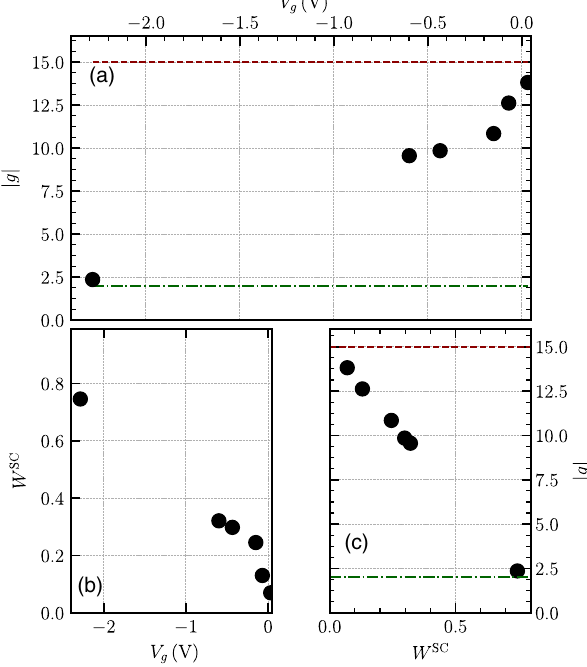
FIG. 11. Gate voltage dependence of (a) the absolute value of effective g factor and (b) the weight in superconductor. Panel (c) relates j g j to the weight in the superconductor W SC . Dots represent typical values for the highest-occupied band at a given gate voltage. The dashed horizontal values are the absolute values of the bare g factor in the semiconductor (red) and super- conductor (green). When the coupling to the superconductor is weak, as indicated by a small weight of the wave functions in the SC, the g factor is close to the bare InAs value. The opposite limit occurs in the strongly hybridized regime at more negative gate voltages.